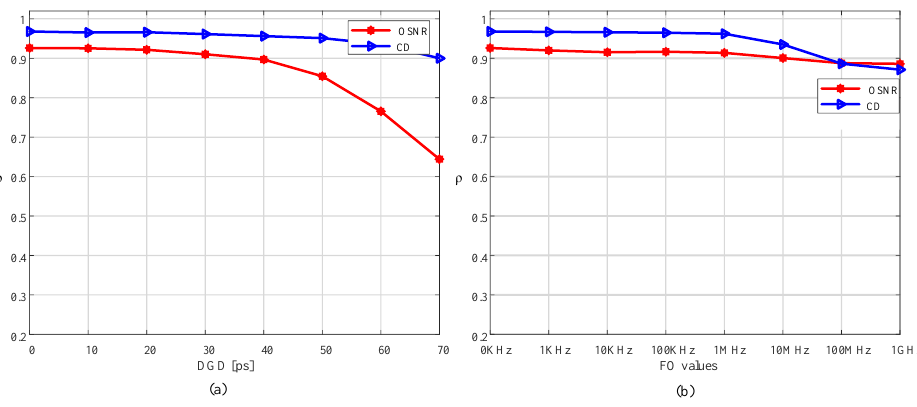
Figure 13. OPM results using V-DCT at different values of ( a ) FO and ( b ) PMD.